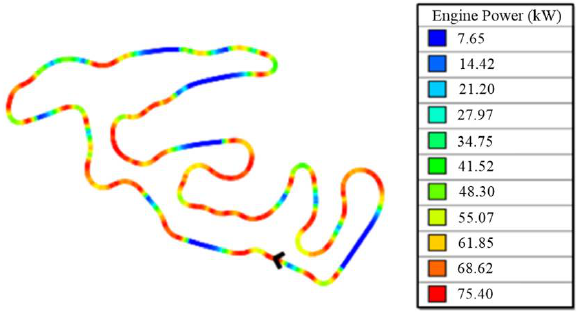
Figure 4. FSAE Autocross Germany track simulation.